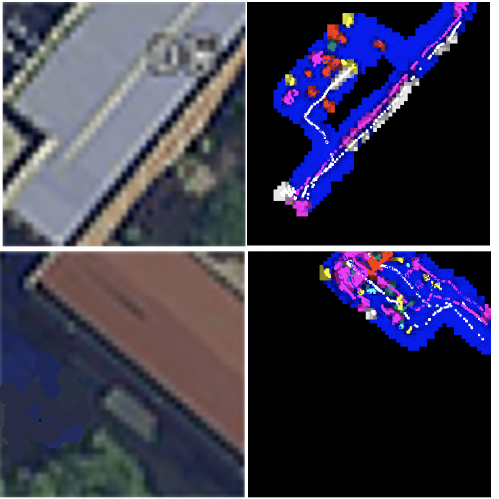
Figure 7. Classification results inside buildings (Education, pink; Information, red; Trajectory without APP, Blue).